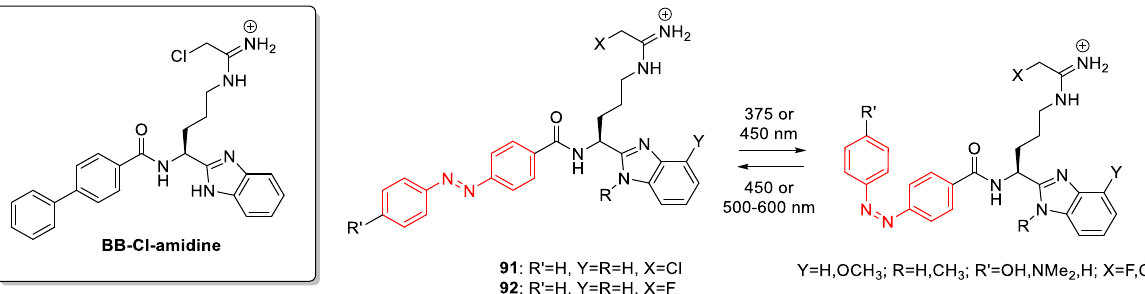
Figure 16. Photoswitchable PAD inhibitors, the photoswitch unit indicated in red.